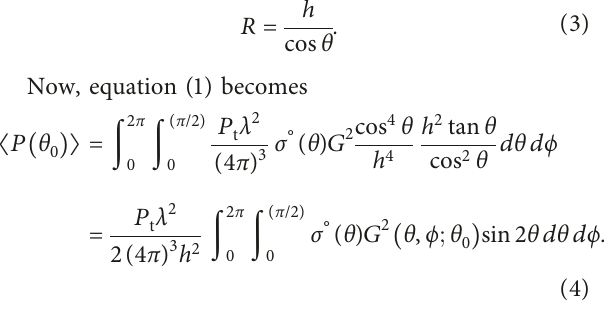
Figure 1: Geometry of radar